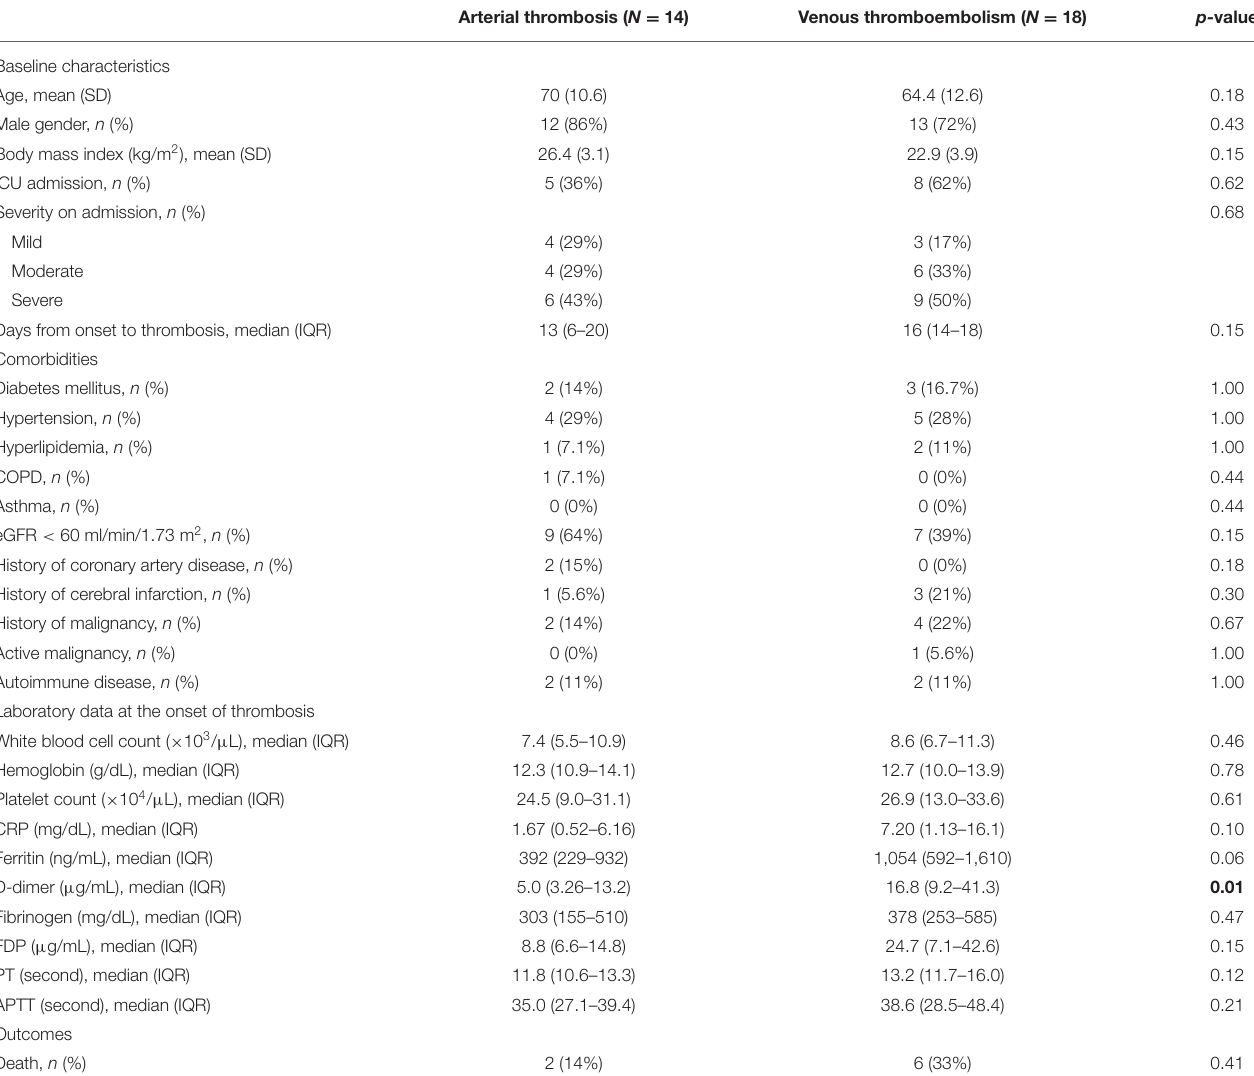
TABLE 3 | Clinical course of the patients complicated with arterial thrombosis or venous thromboembolism. Arterial thrombosis ( N = 14) Venous thromboembolism ( N = 18) p-